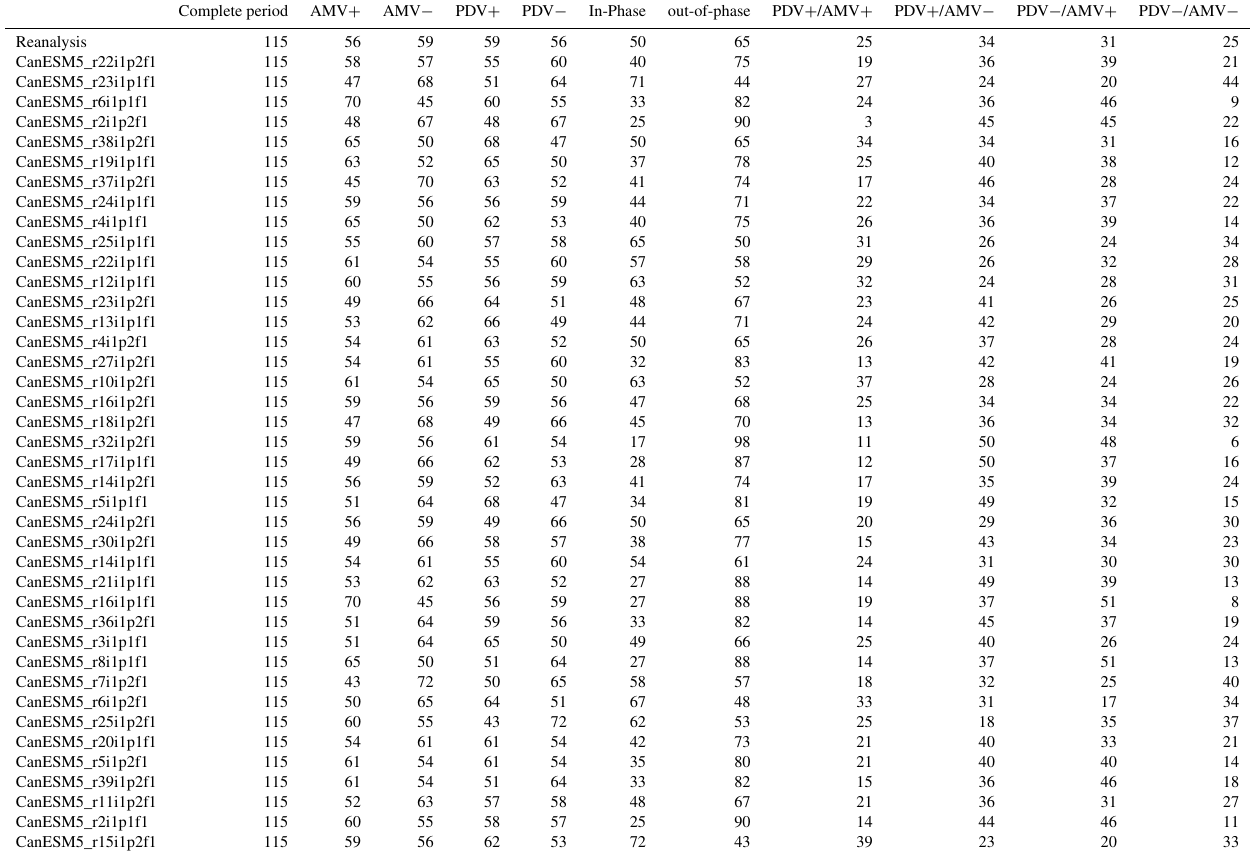
Table A5. Number of years for every regime for reanalysis and CMIP6 simulations